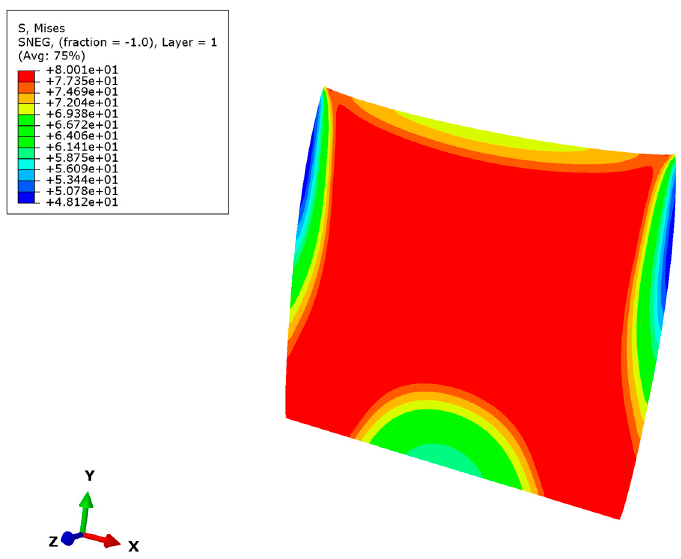
Figure 5. Linear buckling displacement response simulation of Cu plates.